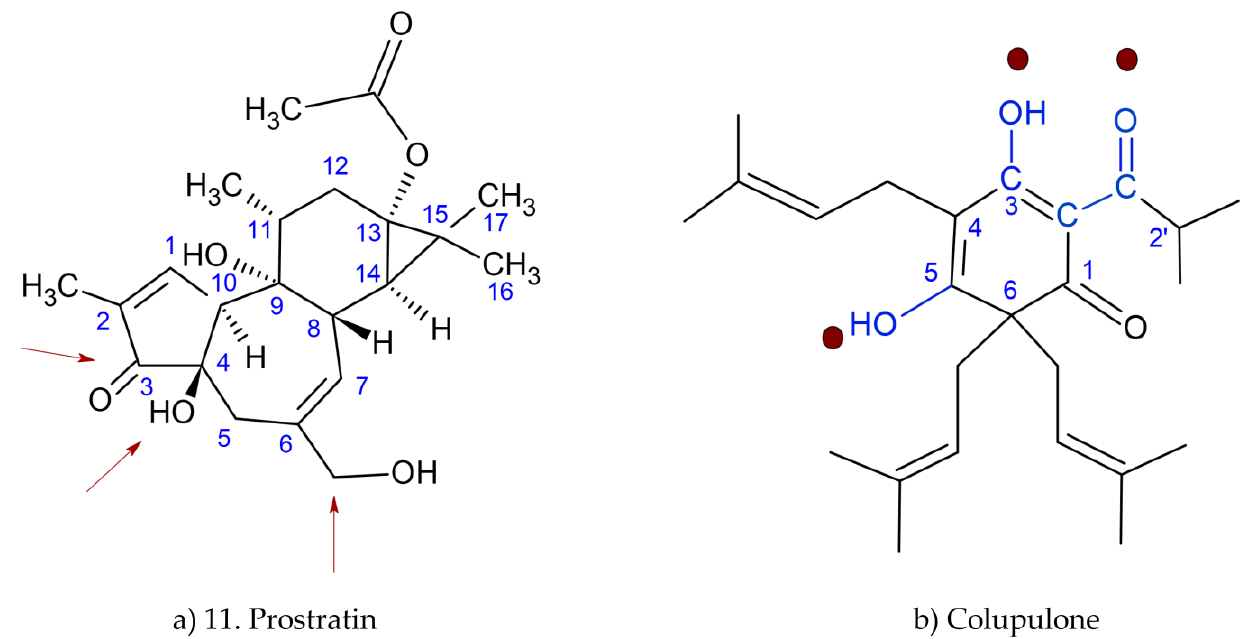
Figure 9. Structure of ( a ) prostratin (11) and ( b ) colupulone indicating groups of plausible interaction with PKC (red dots).